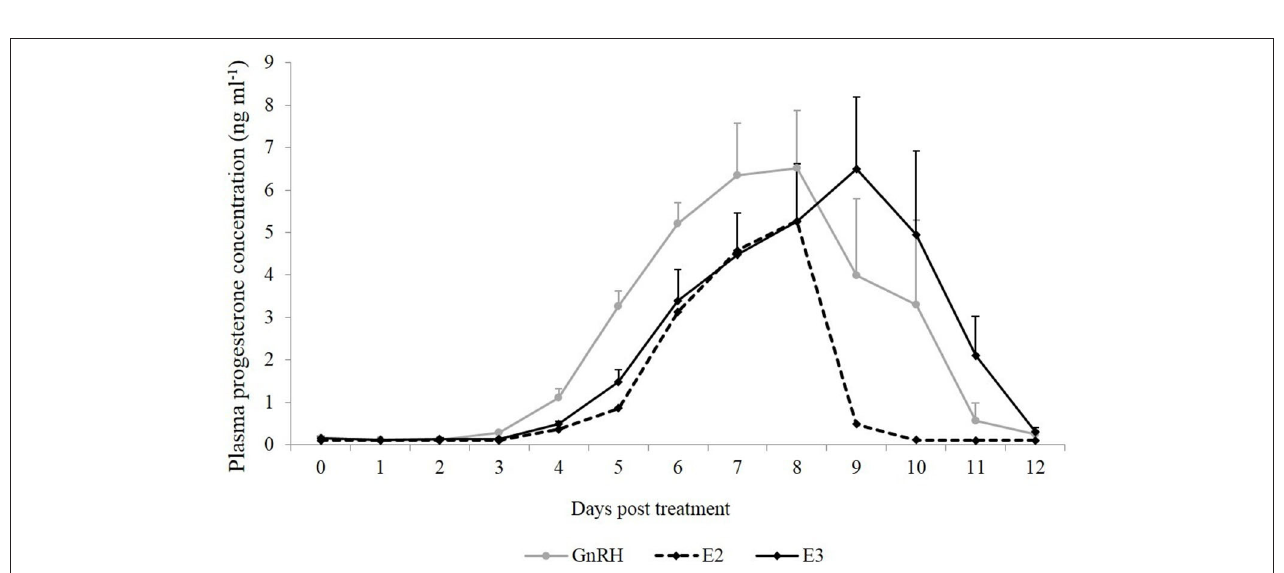
FIGURE 1 | Mean CL diameter (mm) from the first day that CL was detected until Day 12 post-treatment. Gray line: animals treated with Buserelin, analog of GnRH ( n = 6), black line: animals treated with a dose of 1.6mg of estradiol-17 β ( n = 6), and dotted line represents the only llama that ovulated in response to a dose of 1.0mg of estradiol-17 β .